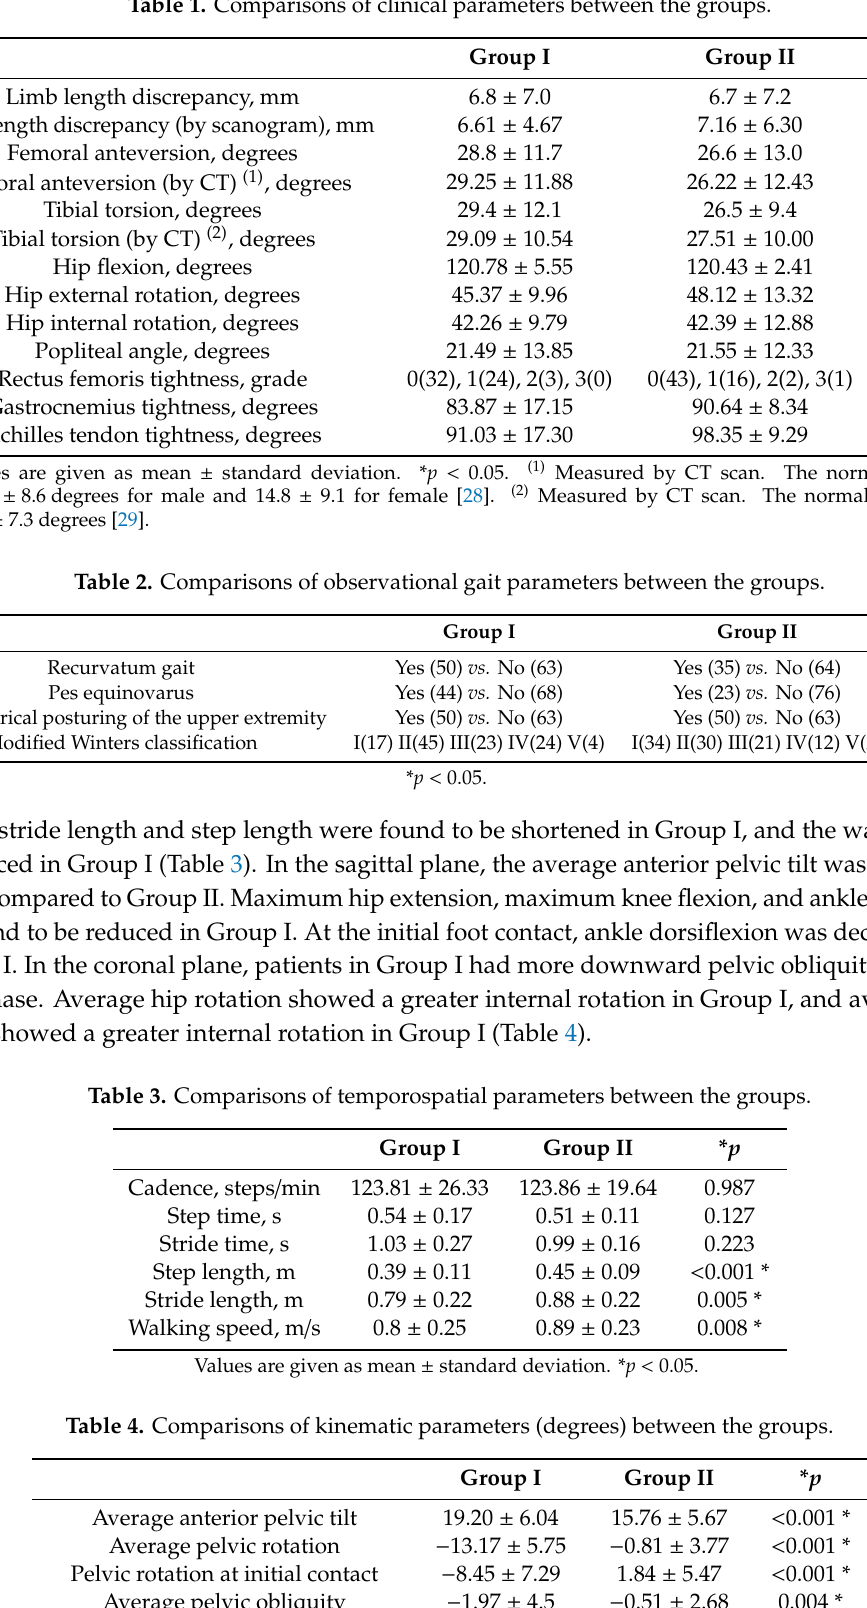
Table 1. Comparisons of clinical parameters between the groups.